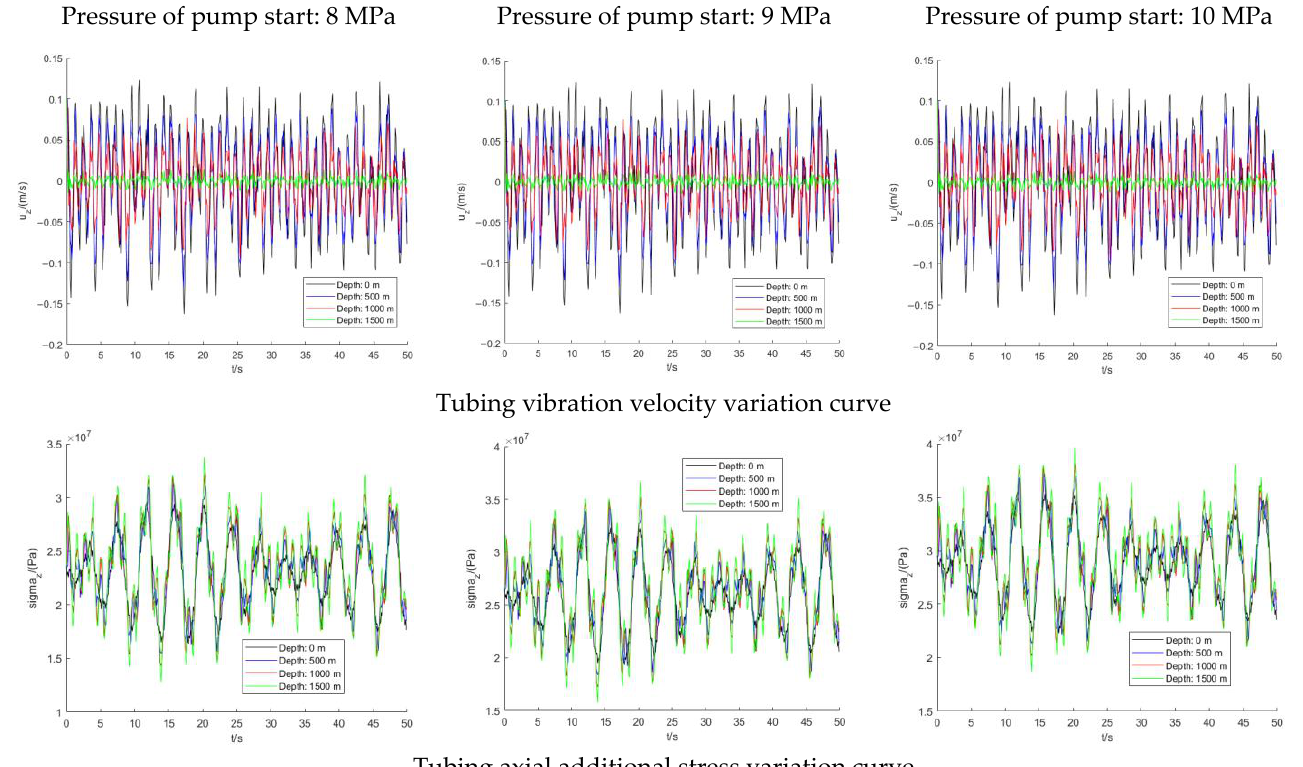
Figure 4. Variation curve of tubing parameters at different initial pump start pressure.